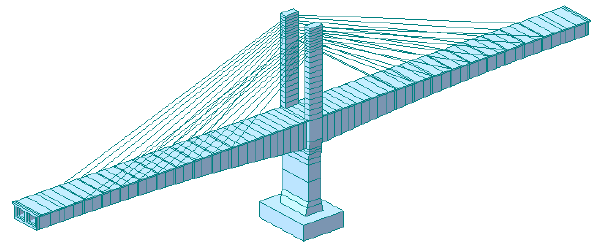
12 of 22 Figure 8. General layout of Nanxi River cable stayed T-frame bridge (unit: cm). 4.1. Numerical Model The whole Nanxi River Bridge is discredited into 220 nodes and 180 elements, and the standard finite element model is established in Midas/Civil. The so-called standard model is a complete bridge model with acting dead weight and two-phase dead load. The spatial beam unit is used to simulate the main girders, piers, and towers. The truss unit is used to simulate the diagonal cables. Nanxi River Bridge is a single-tower cable-stayed bridge with tower and beam consolidation. The properties of the structural members are shown in Table 1 and the boundary conditions are shown in the following Table 2. The parameters in Table 1 are from the Code for Design of Highway Reinforced Concrete and Prestressed Concrete Bridges and Culverts (JTG 3382-2018). The connections between the